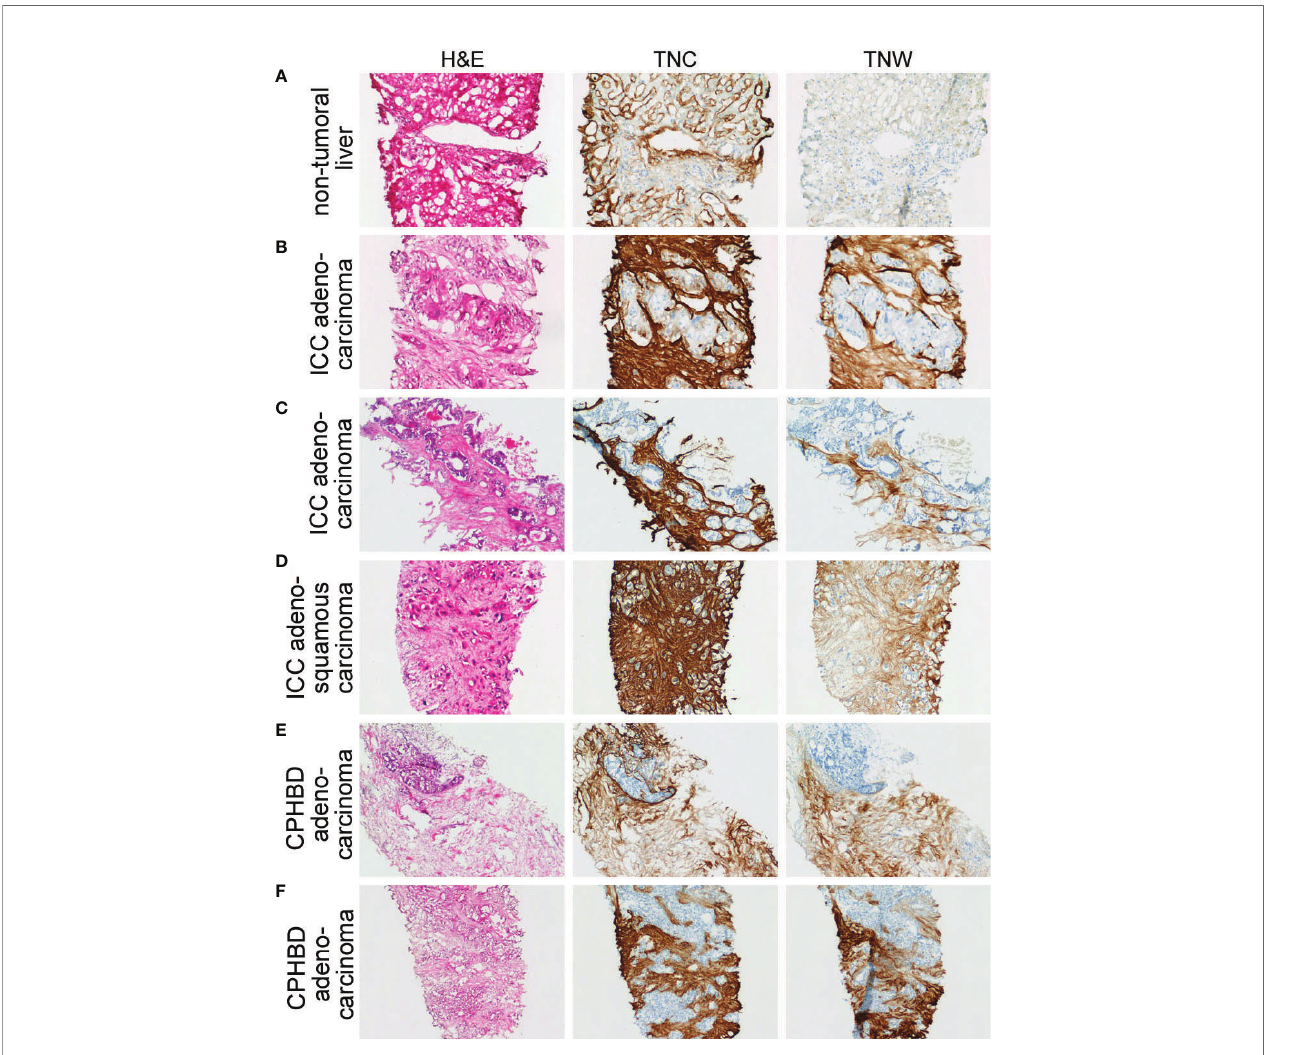
FIGURE 2 | Adjacent sections through needle biopsies of non-tumoral liver and various intrahepatic cholangiocarcinomas and carcinomas of perihilar bile ducts immunostained with anti-tenascin-C (TNC) and anti-tenascin-W (TNW). (A) Non-tumoral liver (patient ID 5) is immunostained with TNC, but not TNW (200X). (B – D) Immunohistochemical examination of intrahepatic cholangiocarcinomas (ICC). Both TNC and TNW label the stroma of a moderately differentiated adenocarcinoma (B) strongly (patient ID 5; 200X). Antibodies to both tenascin-C and tenascin-W label the stroma of a well differentiated adenocarcinoma (Patient ID 1; C ; 100X) and an adenosquamous carcinoma (Patient ID 8; D ; 100X). (E, F) Immunolabeling of carcinomas of perihilar bile ducts (CPHBD) with TNC and TNW. The stroma of a moderately differentiated adenocarcinoma (Patient ID 11; E ; 100X) and a well differentiated adenocarcinoma (Patient ID 13; F ; 100X) show expression of both tenascin-C and tenascin-W. A third section in each series was stained with hematoxylin and eosin